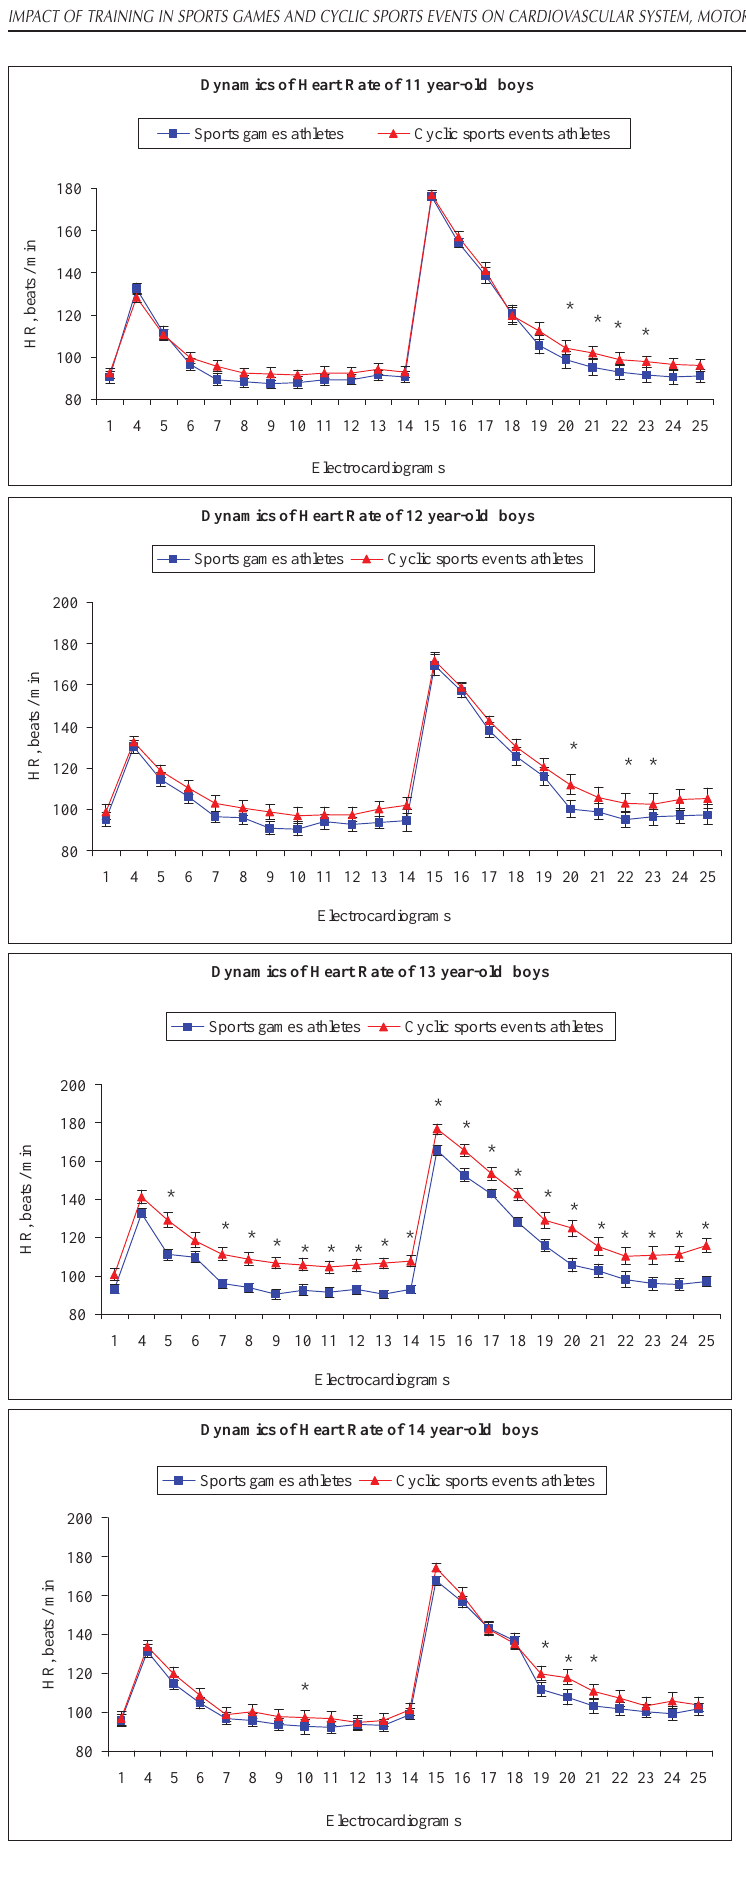
Fig. 2. Dynamics of HR while performing Roufier test and 30 s maximal jumping test in various age groups of boys atending the training session in sports games and cyclic sports